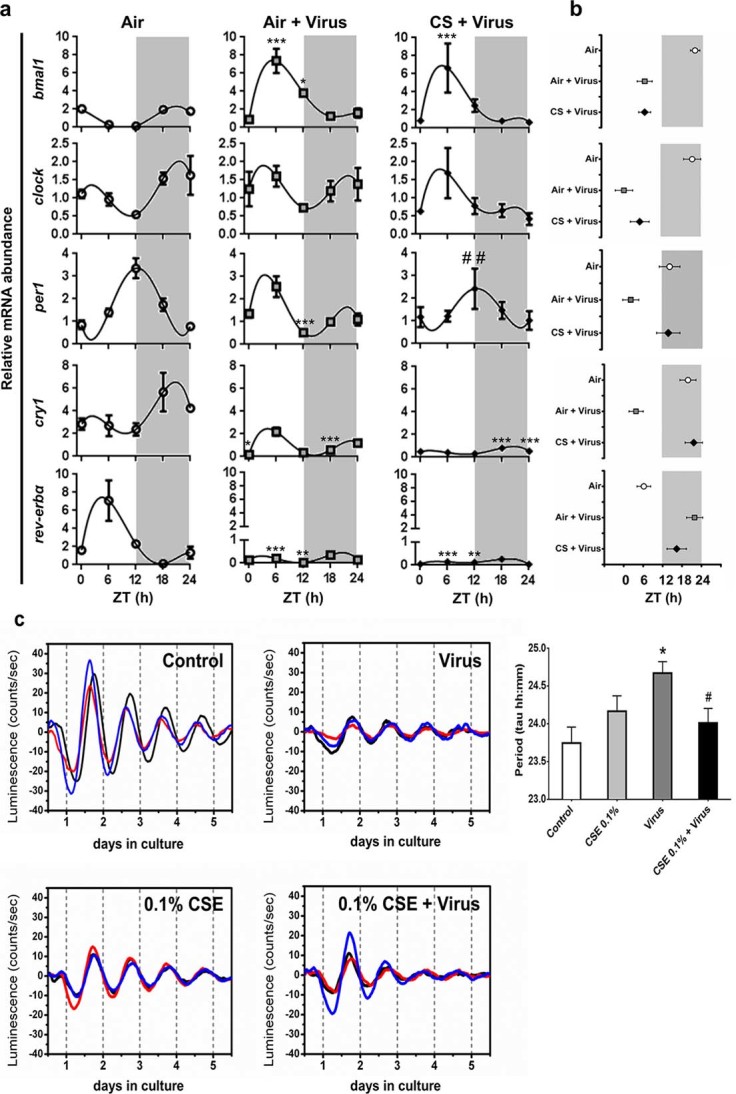
Diurnal rhythms of clock gene expression in the lungs are differentially
affected by chronic CS and IAV infection.Data from uninfected air-exposed mice from a previous experiment were
included for comparison [panels a-b;30]. Lung tissues were harvested every 6 h for 24 h beginning at
ZT0 day 9 post-infection. (a) Expression of core clock genes
(bmal1, clock, per1, cry1, and rev-erbα) in
mouse lung tissue. CircWave analysis confirmed statistically significant
rhythms of clock gene expression in Air+Virus (P < 0.05
for per1 and cry1; P < 0.001 for
bmal1) and CS+Virus (P < 0.05 for per1;
P < 0.01 for bmal1) treated mice. (b)
IAV infection adjusted the phase of clock gene expression in a gene- and
treatment- (Air vs. CS) dependent manner. Center of gravity (COG) or
peak phase for each clock gene was plotted on a horizontal phase map. In
panels a and b, gray shading indicates the relative dark phase (ZT12-24).
Data from air-exposed (open circle), Air+Virus (gray square) and CS+Virus
(solid diamond) mice are representative of mean ± SEM (n = 3-4
mice/group) for each time point. * P < 0.05; ** P
< 0.01; *** P < 0.001 significant compared to
Air group. # #
P < 0.01; significant compared to Air+Virus group.
(c) Effect of CSE and IAV infection on the amplitude and period
of PER2::LUC expression in lung tissue explants. PER2::LUC expression in
representative lung tissue explants treated with medium alone (control),
0.1% CSE, virus alone (IAV, 300 HAU/ml), and 0.1% CSE+Virus. Treatment at
the time of culture with 0.1% CSE and 0.1% CSE+Virus dampened the rhythm of
PER2::LUC expression in lung tissue. Treatment with 0.1% CSE had a small
effect whereas IAV infection significantly increased the period of PER2::LUC
expression in lung explants. This effect was attenuated in explants treated
with 0.1% CSE and IAV. Different colored traces represent tissue explants
from different animals. Data are representative of mean ± SEM (n
= 12-15/group). * P < 0.05 significant compared to control
group; #
P < 0.05 significant compared to Virus group.